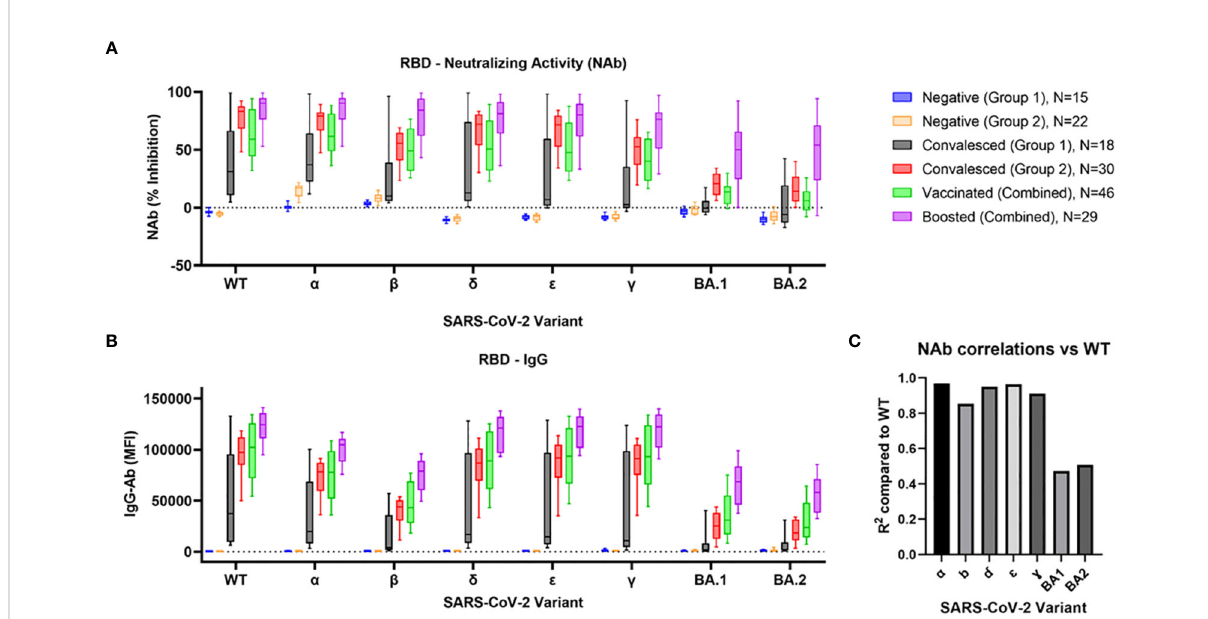
FIGURE 1 Comparison of RBD Nab and Ab to BA.1, BA.2, and prior SARS-CoV-2 variants. Variant-speci fi c neutralizing antibody activity (A) and IgG antibodies (B) were determined in 6 cohorts: 1) COVID-naïve non-vaccinated negative controls collected before the beginning of the pandemic [Negative (Group 1)], 2) negative controls collected during 2021 [Negative (Group 2)], 3) a group of convalesced subjects with predominantly mild symptoms [Convalesced (Group 1)], 4) a second group of convalesced subjects from Stanford Blood Center [Convalesced (Group 2)], as well as groups of vaccinated (Vaccinated), and vaccine boosted (Boosted) individuals. Correlations between NAb activity at each variant compared to wildtype are shown (C)